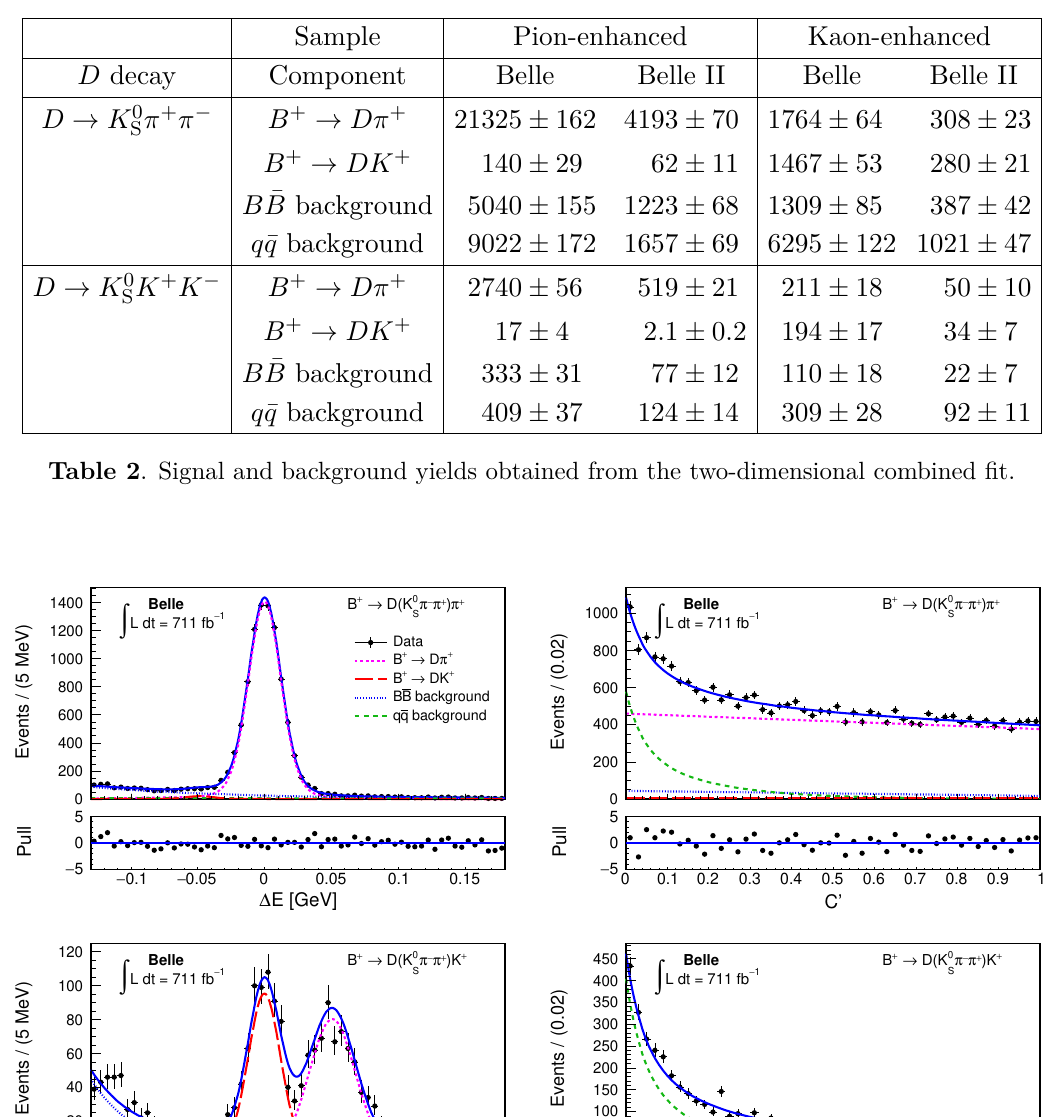
π − π + ) π + and (bottom) S